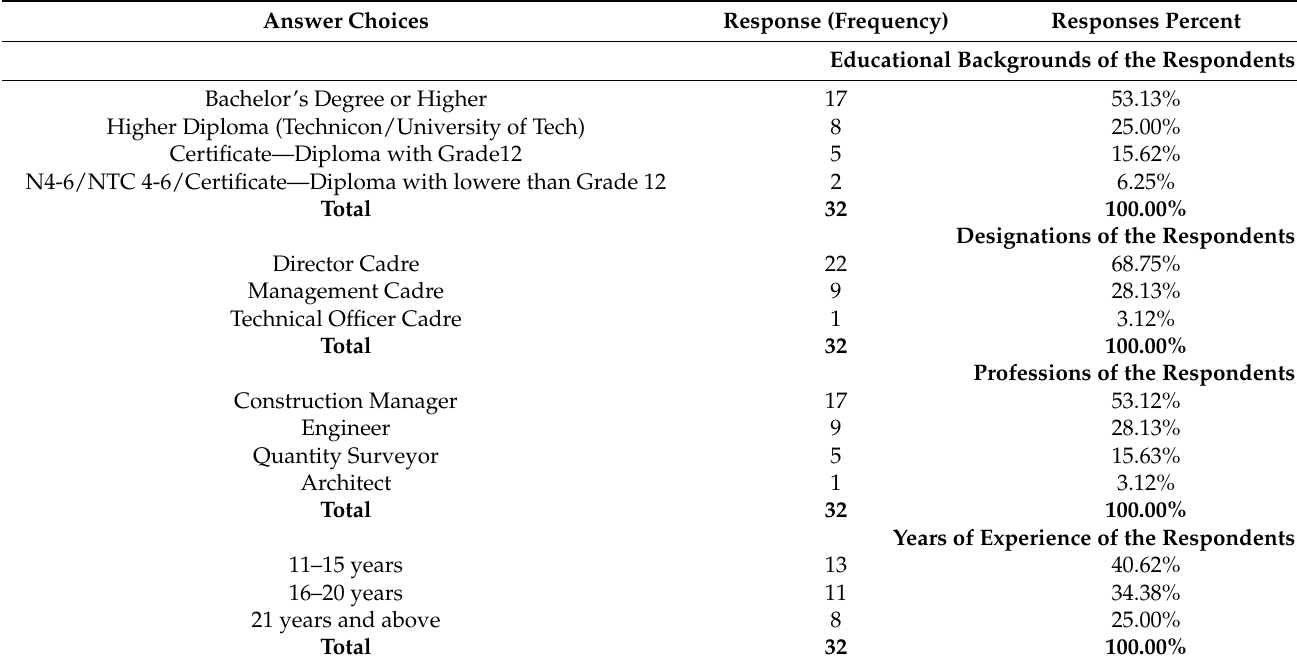
Table 2. Profile of